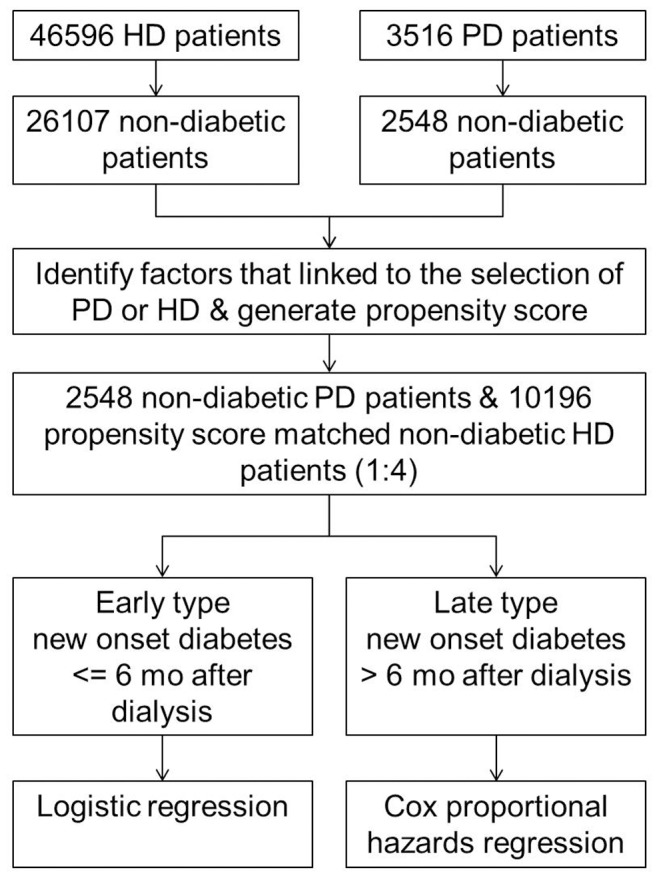
Scheme of study design.Factors used in the propensity score matching are patients’ age, gender, body weight, chronic glomerulonephritis (CGN) as an underlying disease, congestive heart failure (CHF), and number of comorbidity, hypertension (HTN), and patient’ hematocrit. A cohort consists of 2548 peritoneal dialysis and 10192 propensity score matched hemodialysis patients without diabetes was generated. The risk for new onset diabetes mellitus (NODM) was analyzed using logistic regression for early type NODM (patients who developed NODM < = 6 months after dialysis) and Cox proportional hazards regression for late type NODM (patients who developed NODM>month after dialysis).